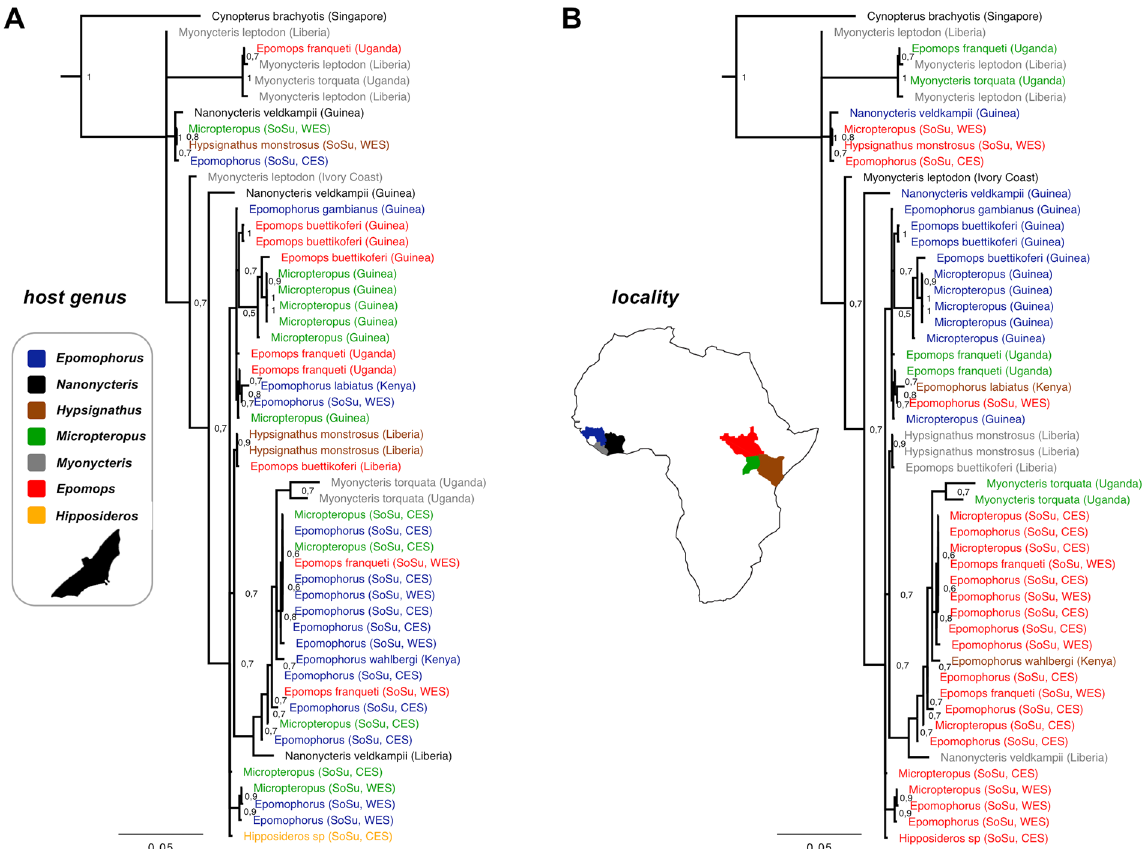
Figure 3. Molecular phylogeny of African bat Hepatocystis parasites (section of Fig. 2). ( A ) Hepatocystis sequences are color-coded by the seven different bat host genera (blue = Epomophorus , black = Nanonycteris , brown = Hypsignathus , green = Micropteropus , grey = Myonycteris , red = Epomops , yellow = Hipposideros ). No strict clustering of the parasite lineages according to their associated host genus is apparent. ( B ) Hepatocystis sequences are color-coded by sampling localities in West Africa (blue = Guinea, grey = Liberia, black = Ivory Coast) and East Africa (red = Republic of South Sudan, green = Uganda, brown = Kenya). No definite geographical pattern is obvious as parasite sequences from West and East African sampling localities are mixed throughout the phylogenetic tree. (Map was created in Adobe Illustrator CS6 Version 16.0.0., http://www.adobe.